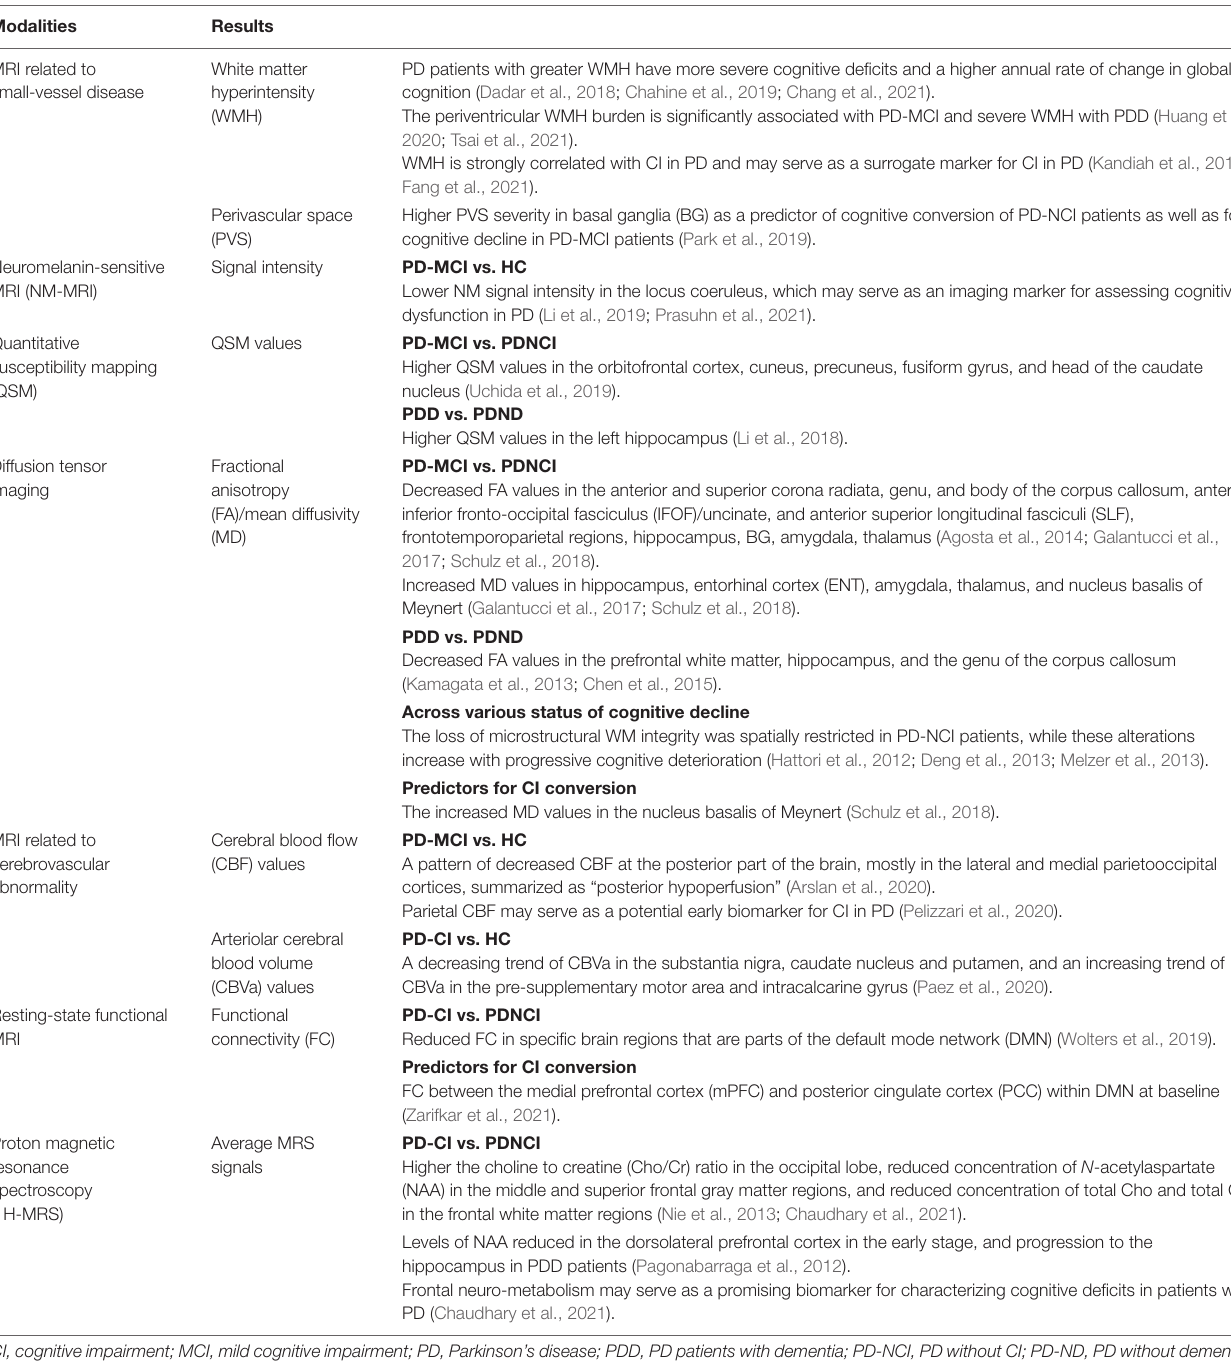
TABLE 3 | Summary findings from other magnetic resonance imaging studies in Parkinson’s disease and cognitive